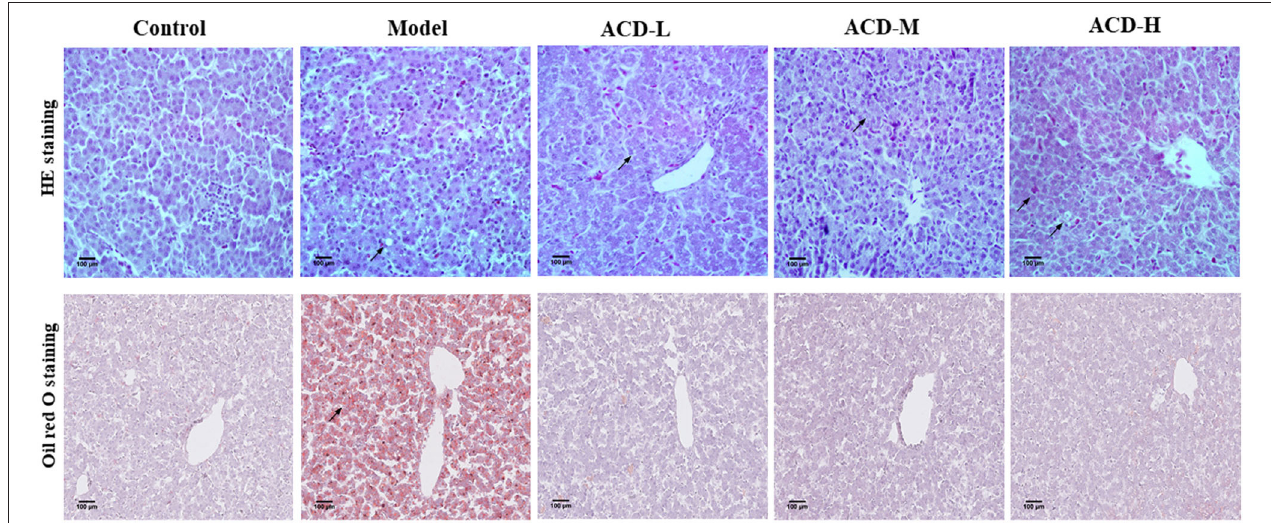
FIGURE 2 | Effects of decoction of Abrus cantoniensis Hance (ACD) treatment on pathological results of the liver in laying hens. Liver sections were stained with HE and red oil O, the fatty degeneration and lipid droplet accumulation were indicated by the arrowhead. ACD treatment improved hepatic steatosis in laying hens with fatty liver hemorrhagic syndrome (FLHS).